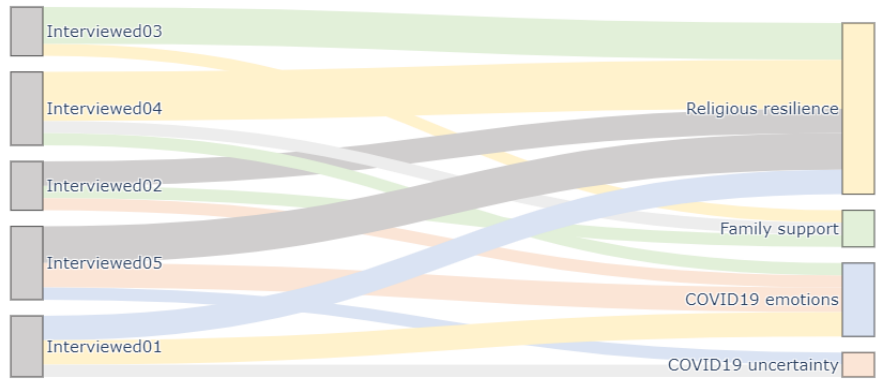
Figure 4. Sankey diagram—occurrence code groups with Respondents 1–5.